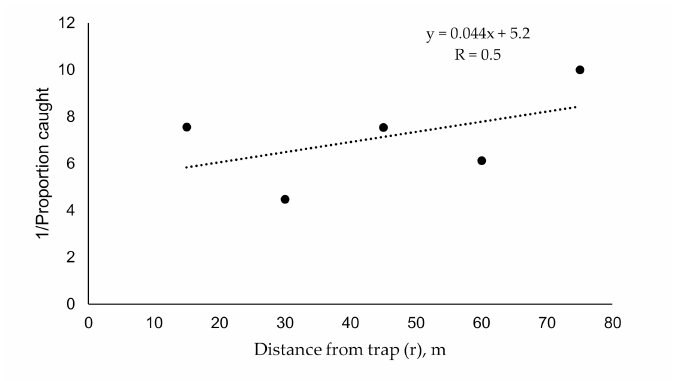
Figure 2. Inverse of proportion of gypsy moth males caught in pheromone-baited traps released at various distances from traps (r) (MAG plot transformation [28]). The proportion was calculated as an average over nine catches for each distance.